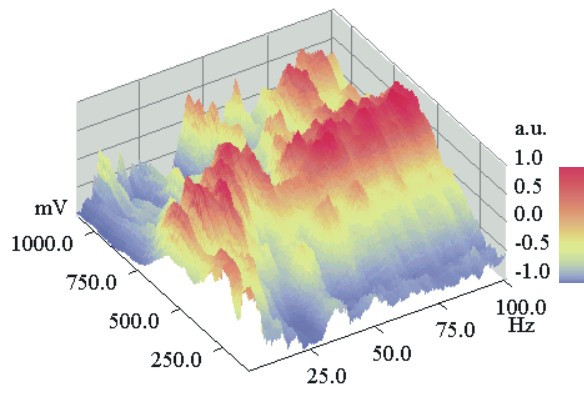
DNLDS resolved voltammogram dataset (normalized to voltage axis):The same dataset and representation style like Figure 9, but with normalization of the single voltammograms for each frequency. For low frequencies (<5 Hz) Voltammograms have a maximum at about 250 mV, comparable to the pure DC volt scans. But with rising spectral harmonics voltammetric maxima occur at about 700 mV with overlaying intensity patterns of 4 and 16 Hz in distance. Worthy of remark are 62, 78 and 94 Hz, these all are four folds of the used base ICR resonance frequency 4.14 Hz.